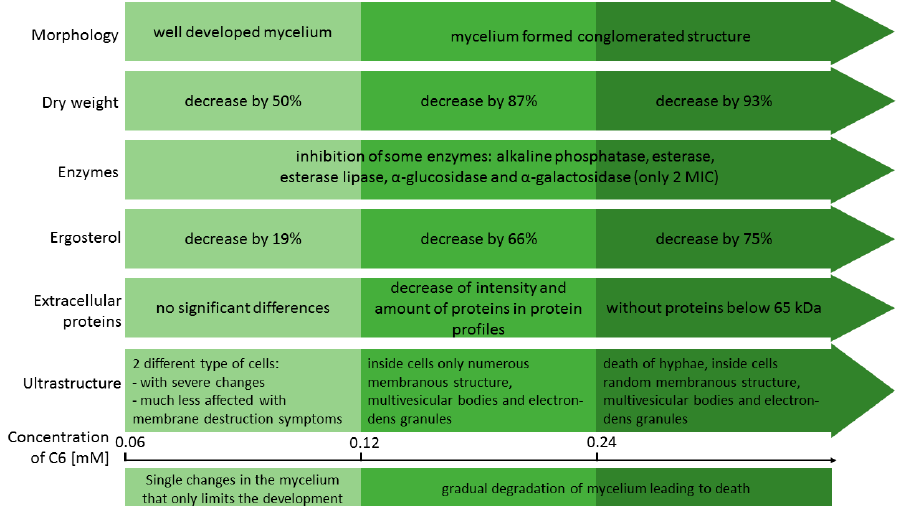
Figure 3. Representation the stepwise antifungal action of hexamethylene-1,6-bis-( N , N -dimethyl- N -dodecylammonium bromide) C6 against mycelium of Aspergillus brasiliensis ATCC 164040 in comparison to mycelium without gemini surfactant.